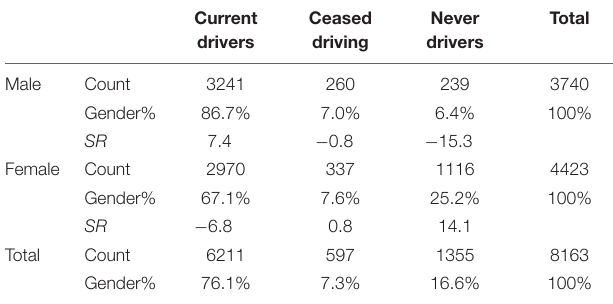
TABLE 2 | Crosstabulation of gender by driving status. Current